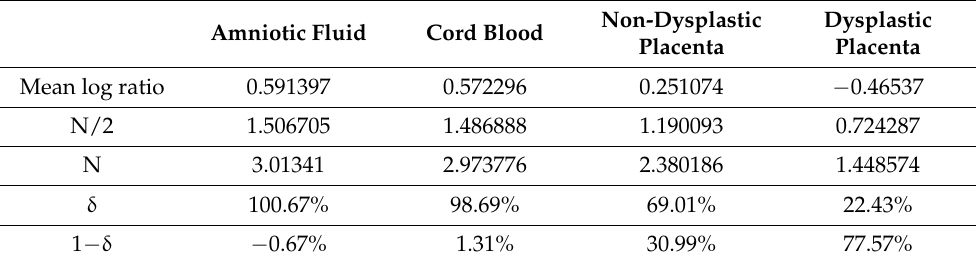
Figure 3. Histology of dysplastic placenta. ( a ) Dysplastic villi under hematoxylin–eosin stain. An edematous, dysplastic villi was surrounded by some normal villi, showing a mosaic pattern of histological appearance; ( b ) Chorangiosis in dysplastic villi; ( c ) P57 stain of dysplastic villi. No nuclear uptake in stroma is seen, indicating no expression of maternal genome; ( d ) P57 stain of normal villi. Nuclear stain in stroma is seen. Table 1. Mosaic analysis of array